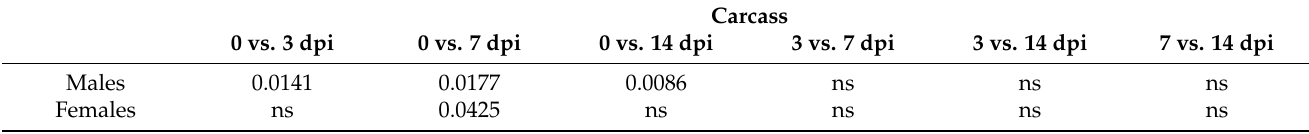
Table 1. Summary of statistical analysis of viral growth in male and female carcasses. Multiple t -tests with Bonferroni correction were performed to determine p -values; below, the p -values are shown for carcasses of both sexes compared between all measured time points